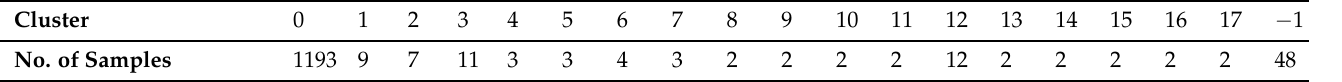
Table 7. Clusters identified by the Mean-shift